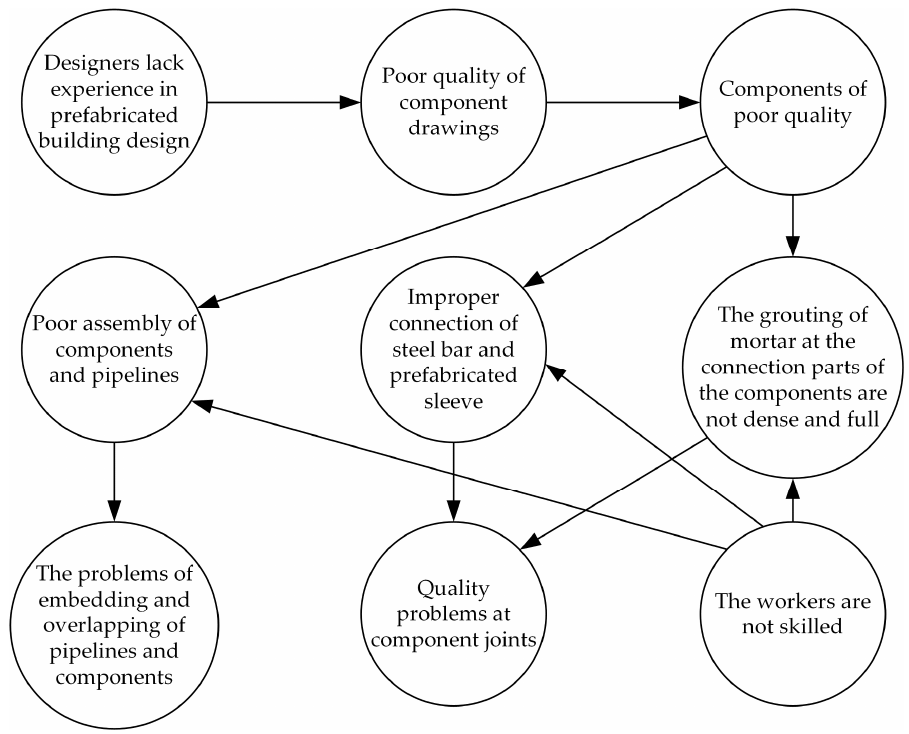
Figure 2. Interrelationship digraph of some quality control factors.